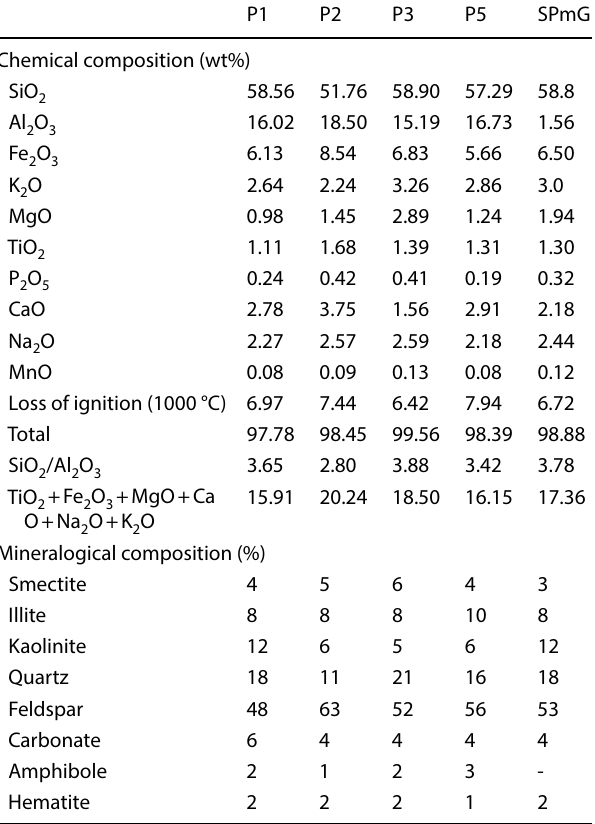
Table 4 Mineral and chemical composition of Boulgou clayey soils